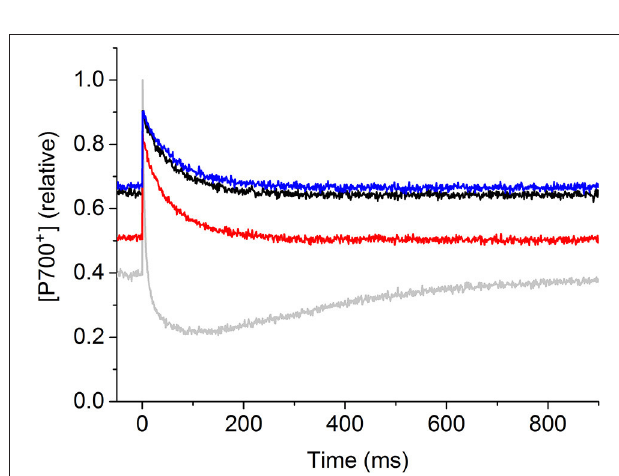
FIGURE 3 | Representative P700 + kinetics signals of P. decussata when linear electron flow was chemically blocked by DCMU. Measurements were done at 25 ◦ C (control, black line), at 33 ◦ C (heat, red line), and 25 ◦ C after the heat treatment (recovery, blue line) all in the presence of 40 µ M DCMU. Grey lines show the control signal in the absence of DCMU (recorded at 25 ◦ C). The same illumination protocol was applied as shown and described in Figure 1 . P700 + signal intensity is shown in relative units as [P700 + ]